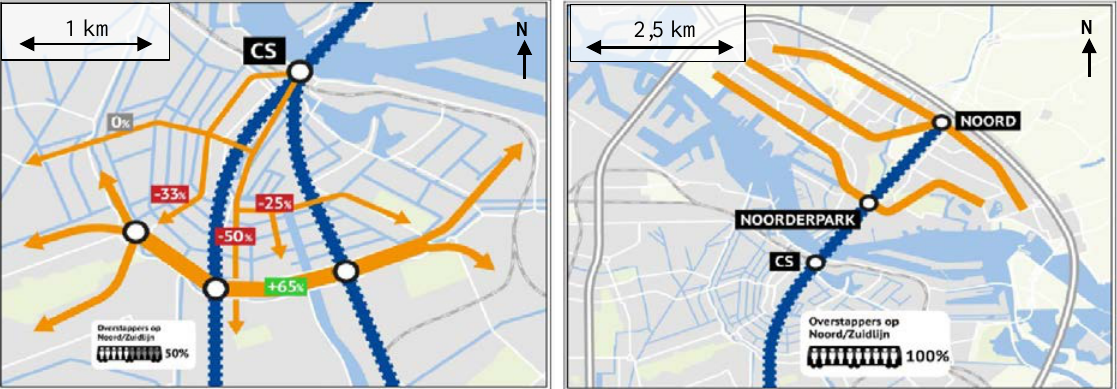
Figure 3. Conceptual visualisation of network changes in the tram network (left) and the bus network (right). Metro is shown in blue (the most Western metro line is the new north-south line) and trams and buses are shown in orange (Stadsregio Amsterdam, 2015)